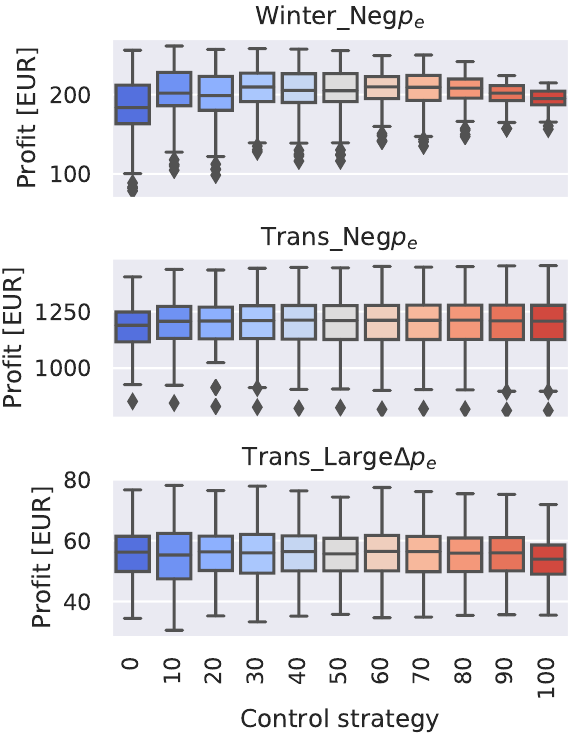
Figure 7. Box plots of the profits obtained with the 11 selected control strategies on all GenkNET versions for three different days. The box plots shows the median, first and third quartile and the minimum and maximum (excluding outliers) of a data set. The outliers are represented by the diamond markers. On the Winter_Negp e day, the profit variation decreases as higher optimal control strategies are applied. Looking back at Figure 6, this is likely caused by the quick succession of two negative price periods. When a higher heat demand is predicted, a large supply temperature pulse is applied